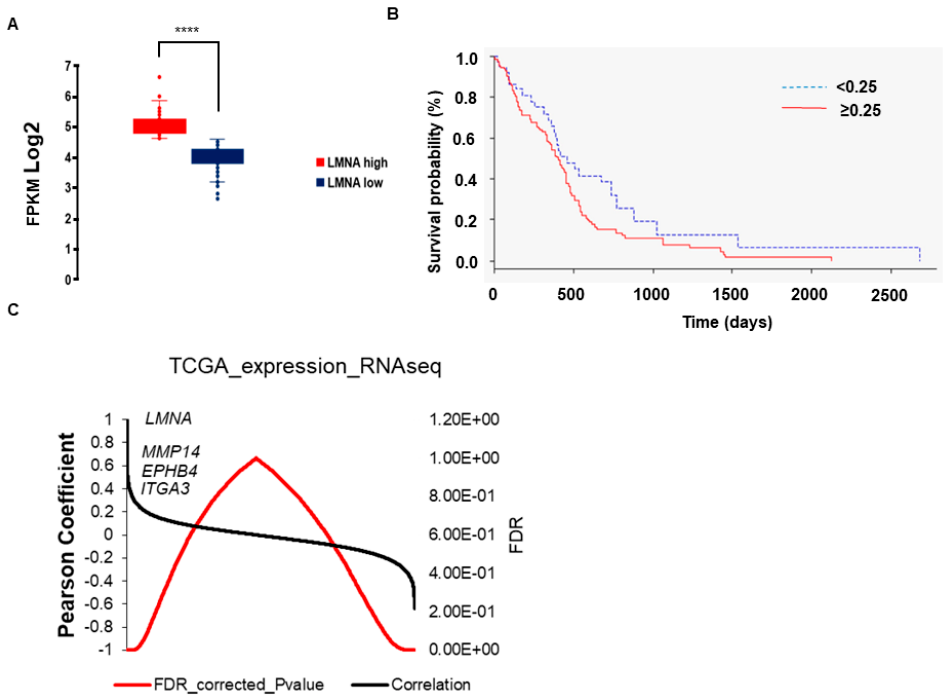
Figure 1. Analysis of LMNA gene expression in GBM patients from The Cancer Genome Atlas (TCGA) RNAseq data. ( A ) Distribution of LMNA gene expression in 152 GBM patients from TCGA RNAseq data. FPKM (Fragments per kilo base per million mapped reads). Statistical significance: LMNA high vs LMNA low **** p < 0.0001. ( B ) Kaplan-Meier overall survival curves comparing LMNA high ( ≥ 0.25) and low (<0.25) GBM patients from the TCGA database (Z = 2.1; p = 3.5 × 10 − 2 ). ( C ) Correlation analysis between LMNA gene and all other reported in the TCGA RNAseq data. Correlation data are reported in Pearson coefficient and error data in FDR.